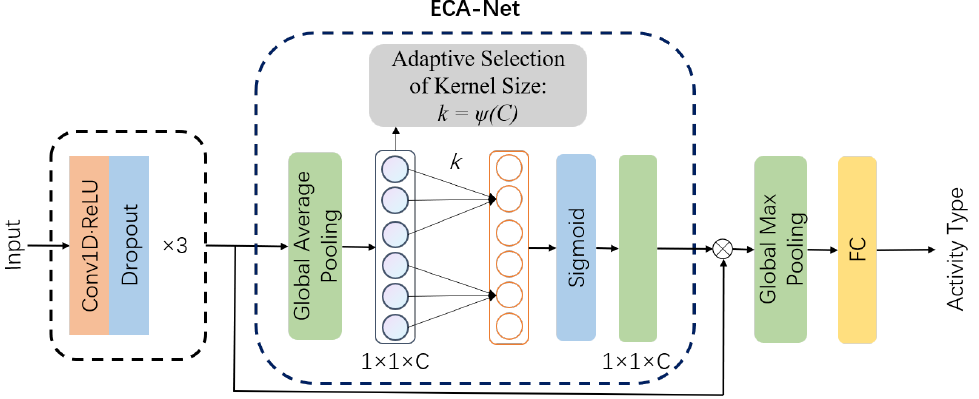
Figure 8. The improved TPN backbone network